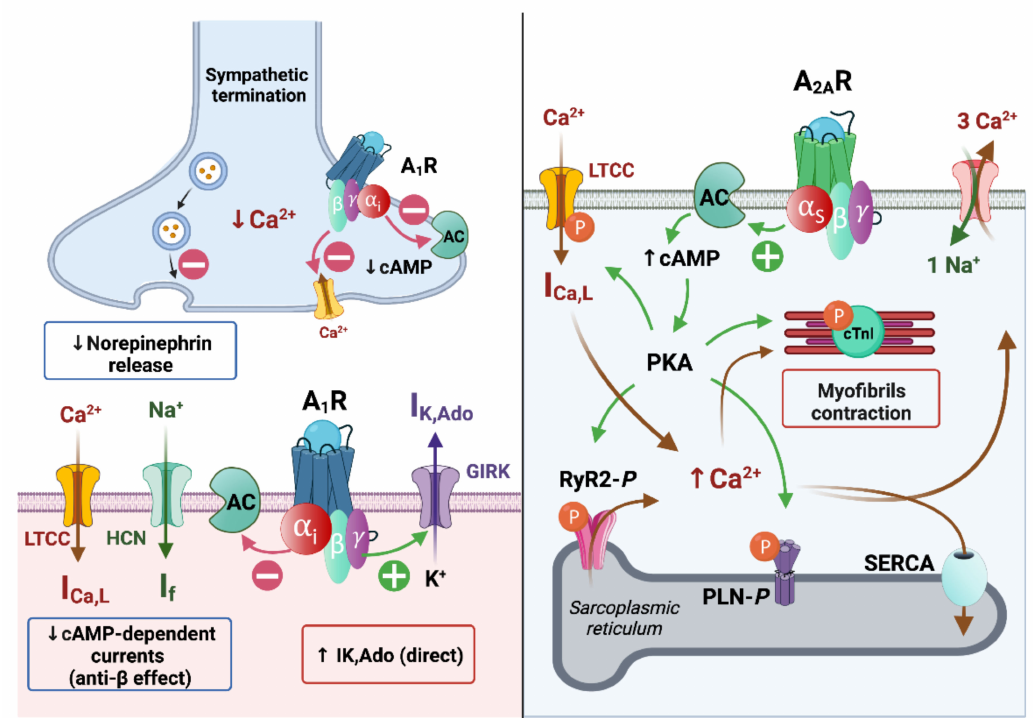
Figure 3. Adenosine receptors signaling ( right : A 1 R; left : A 2A R). Prejunctional A 1 R activation limits the norepinephrine release. Complementarily, A 1 Rs reduce the increased adrenergic-induced cAMP elevation and the cAMP-dependent currents (I funny, ICa,L). The main effect of A 1 R activation is mediated through GIRK-induced outward K+ current (IK,Ado). A 2A R activation increases cAMP and, consequently, activates the PKA. PKA phosphorylates L-type Ca 2+ channels (LTCC) inducing an inward Ca 2+ current (ICa,L). Ryanodine receptors’ (RyR2) phosphorylation by the PKA allows for the Ca 2+ -induced Ca 2+ release from the sarcoplasmic reticulum. Cardiac troponin I phosphorylation and cytosolic Ca 2+ sparks trigger the myofibrils’ contraction during systole. During diastole, the phosphorylation of phospholamban (PLN) permits the SERCA to pump Ca 2+ into the sarcoplasmic reticulum. The Na + : Ca 2+ exchanger extrudes Ca 2+ allowing for diastolic relaxation. AC: adenylyl cyclase; cTnI: cardiac troponin I; PKA: protein kinase